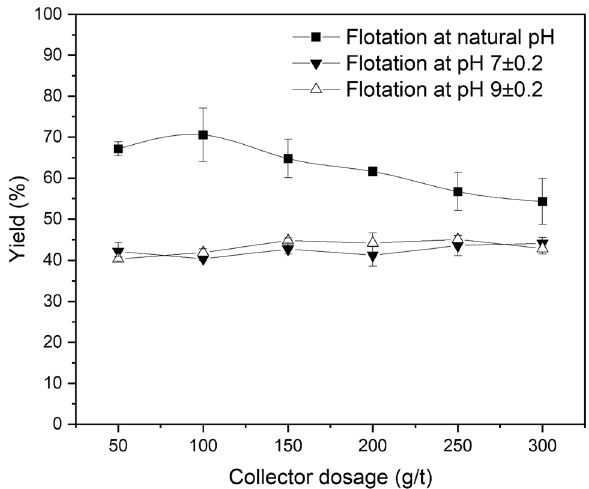
Figure 10. Effect of Collector Dosage on Flotation of LiAlO 2 using bis(2-ethylhexyl) phosphate at natural pH, pH 7 and pH 9.